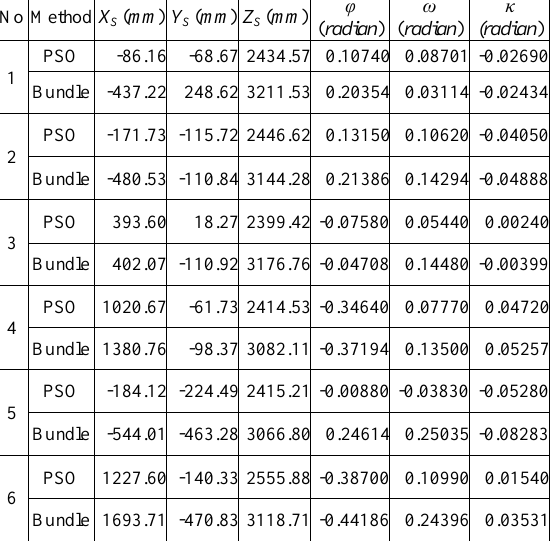
Table 4. Exterior orientation elements calculated by PSO and Bundle adjustment (six control points)